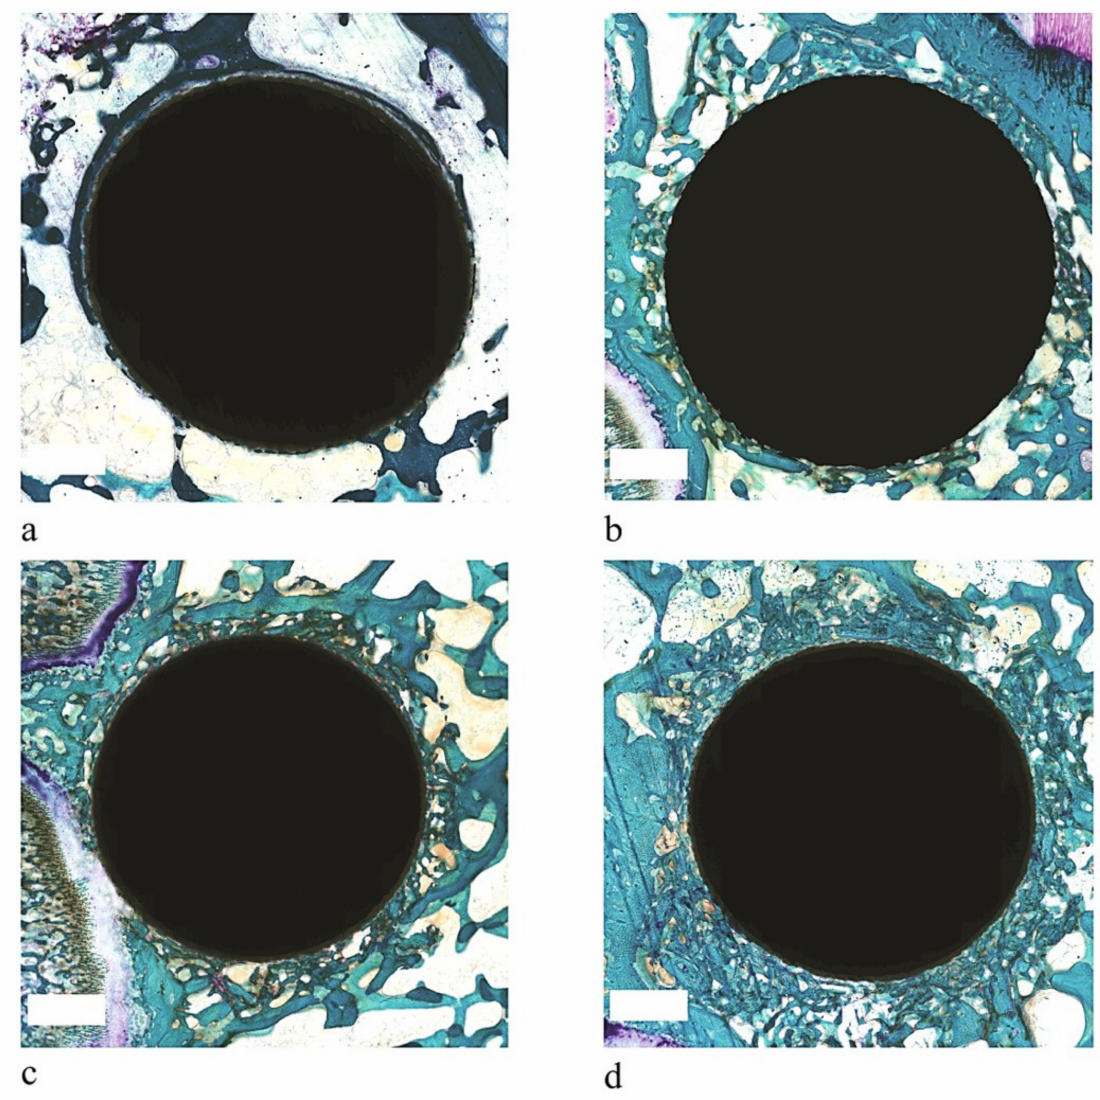
Figure 1. Histological images at 2 weeks: ( a ) Ti-HA; ( b ) Ti-HA+ BMSC; ( c ) Ti-HA + PRP; ( d ) Ti-HA + BMSC + PRP. Toluidine Blue, Acid Fucsin, Fast Green staining; magnification 2.5 ×